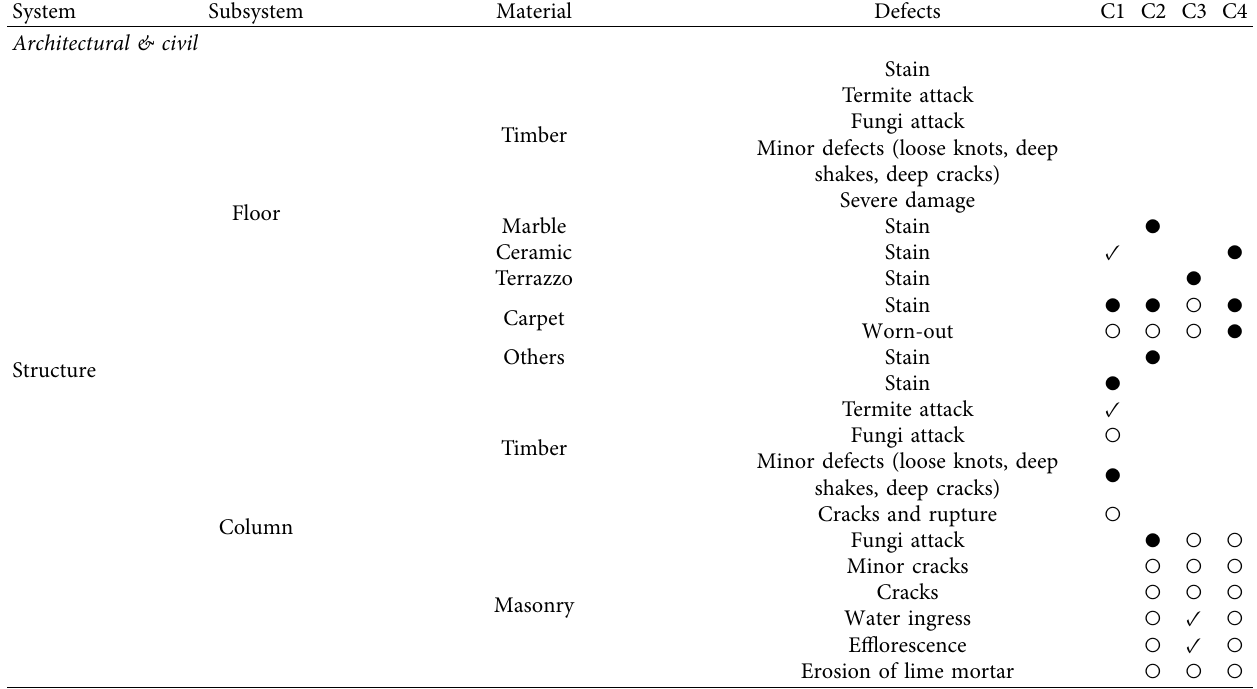
Table 4: Defects of surveyed Anglican churches according to their